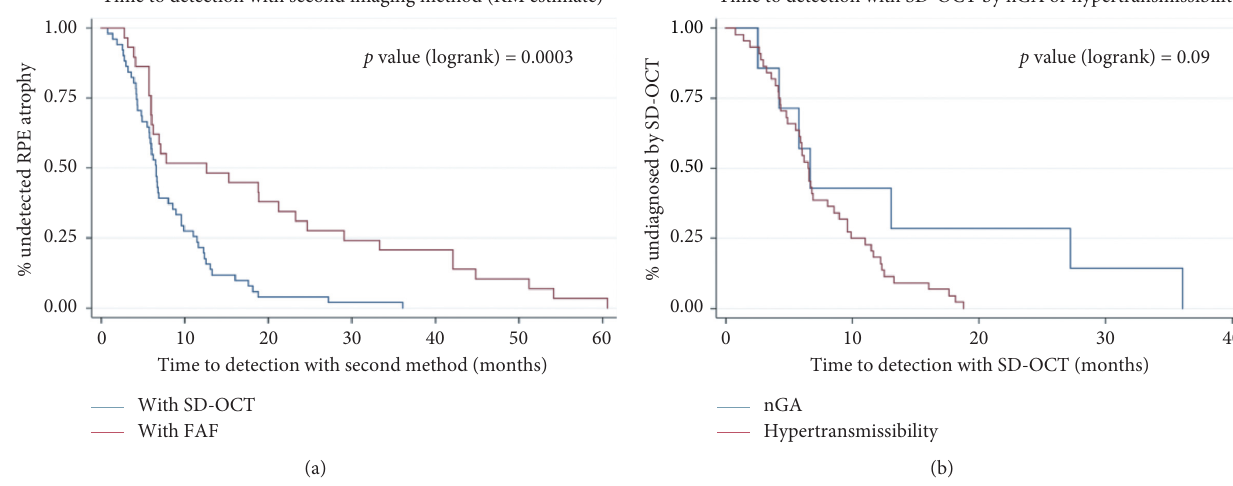
Figure 4: Comparison of time to secondary detection of incipient GA. FAF: fundus autofluorescence; nGA: nascent geographic atrophy; SD-OCT: spectral domain optical coherence tomography. (a) On the left-hand side, the Kaplan–Meyer curves of time to detection with SD- OCTwhen FAF detected atrophy earlier (blue) and with FAF when SD-OCTdetected atrophy earlier (red) are shown. (b) On the right-hand side, the Kaplan–Meyer estimates compare if earlier detection was made by showing choroidal hypertransmission or nGA when SD-OCT detected the